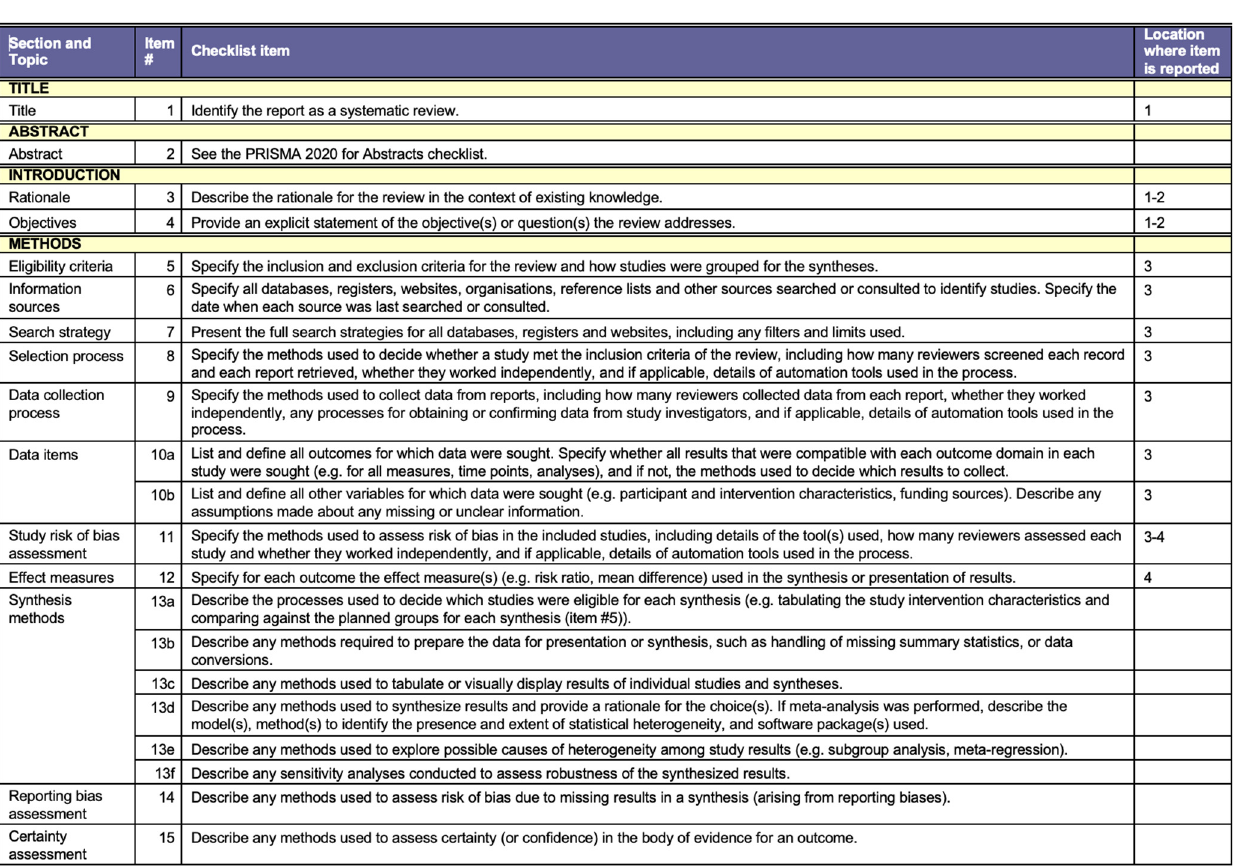
Figure A1. PRISMA Checklist.